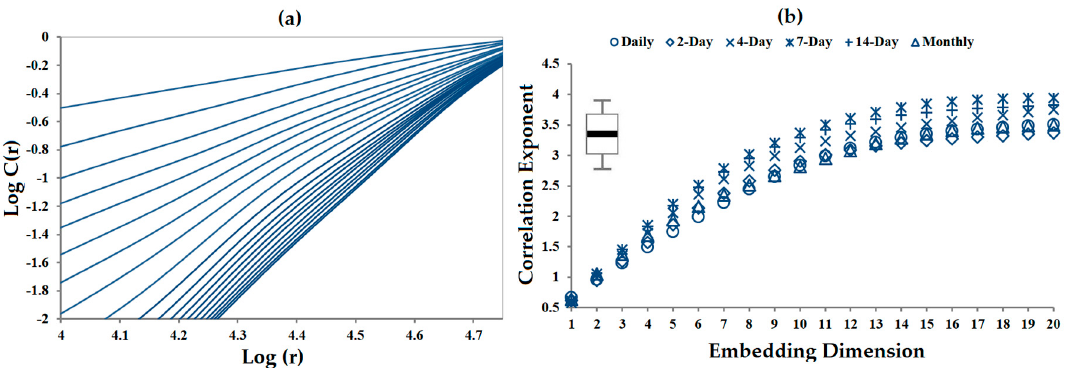
Figure 5. ( a ) The relation between correlation integral C ( r ) and r by different embedding dimensions for daily temporal scale, ( b ) saturation of correlation dimension C e ( m ) with embedding dimension m for different temporal scales.